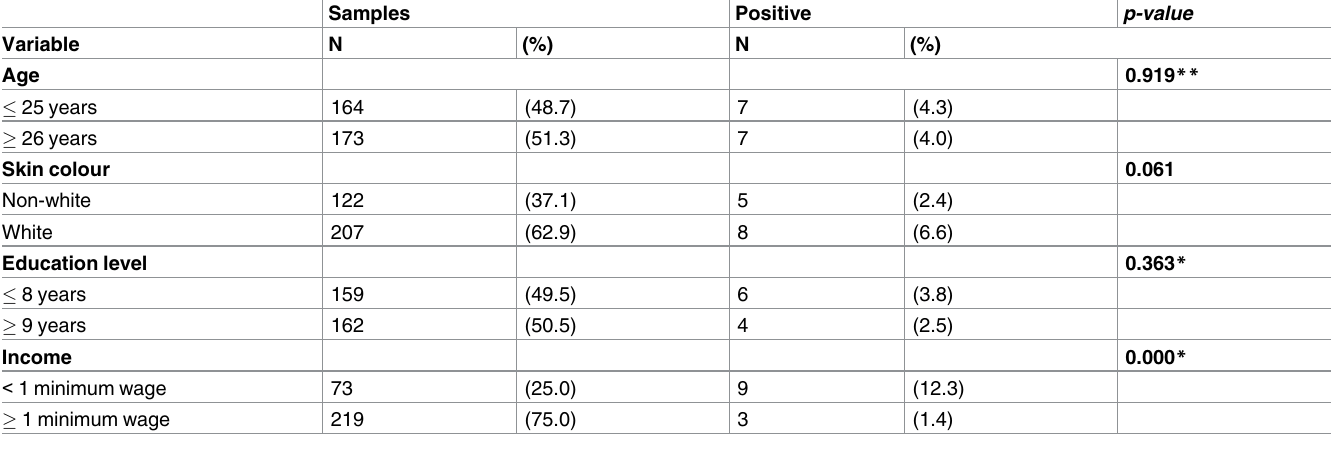
Table 2. Bivariate analysis of the sociodemographic data of women treated at the University Hospital of Rio Grande, Rio Grande do Sul, Brazil. Trichomoniasis was diagnosedusing polymerasechain reaction(PCR) with the TVK3/7 primer set. Period betweenJanuary2012 and January2015 (n =